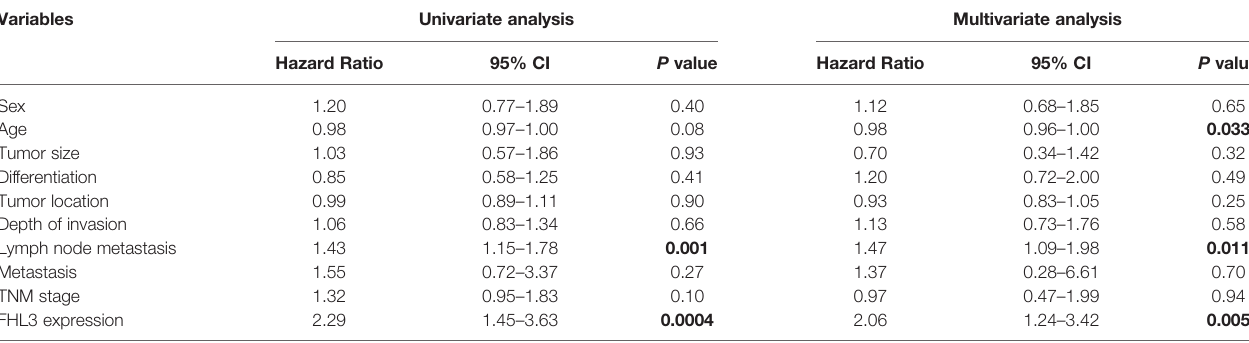
TABLE 2 | Univariate analysis and multivariate analysis of overall survival in 120 gastric cancer patients.